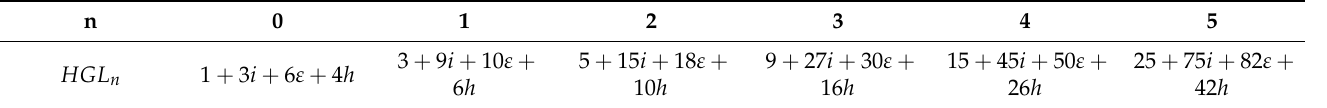
Table 3. Some hybrid Gaussian Leonardo